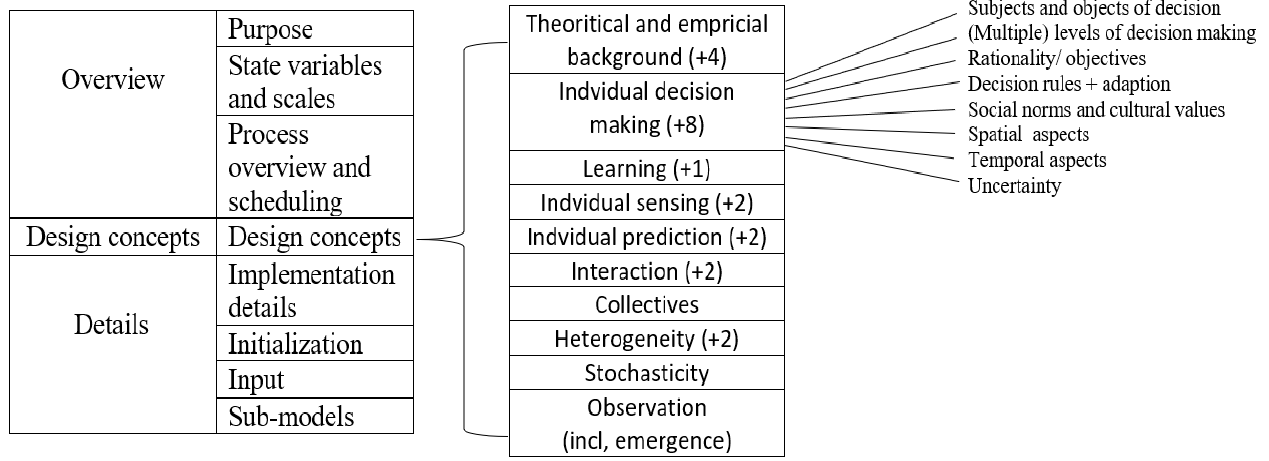
Figure 2. ODD+D protocol [12]. Plus sign (+) indicates numbers of added new questions (compared to the previous ODD).